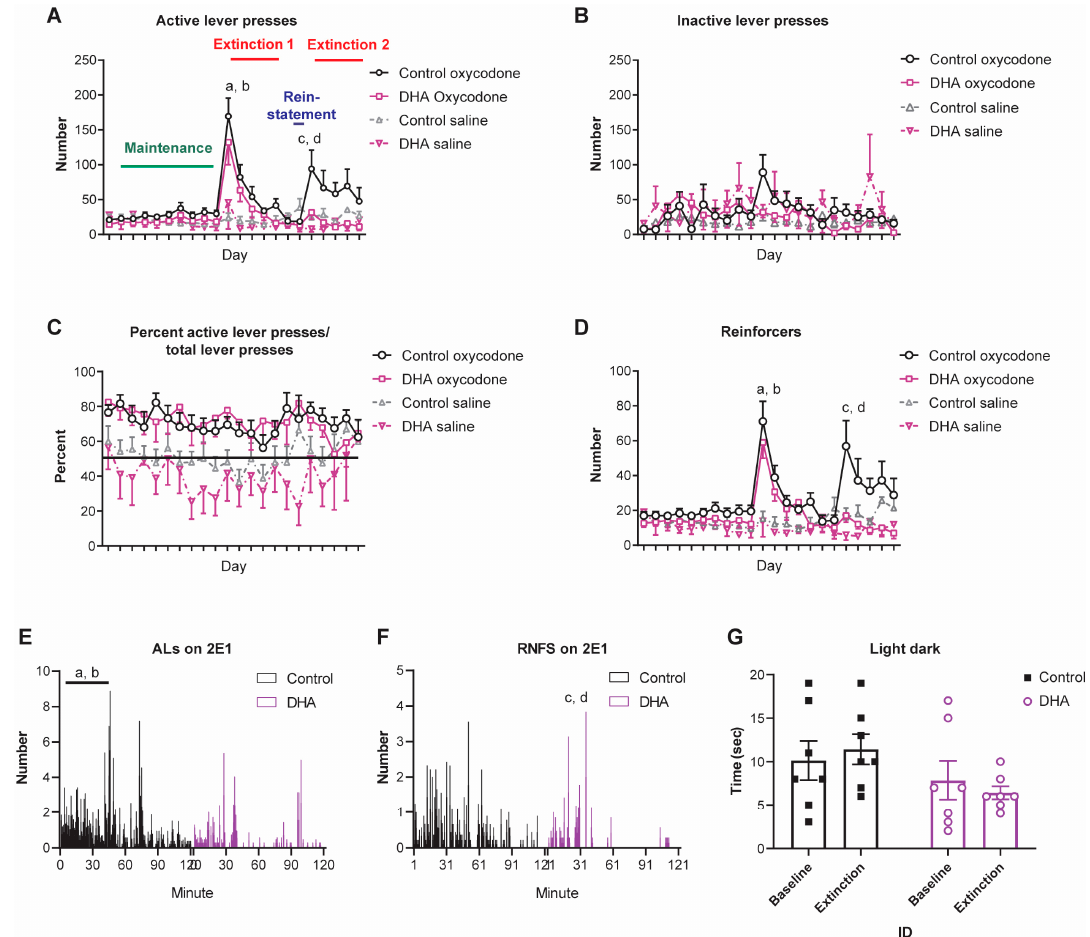
Figure 2. An n-3 PUFA-enriched diet reduces oxycodone seeking behaviors. ( A ) Active lever presses. Mice on both the control diet (black) and the n-3 PUFA-enriched diet (purple) showed an increase in AL pressing on the first day of 1E (a; p < 0.0001) and a decline in lever pressing thereafter (b; p < 0.0001). AL pressing during the reinstatement did not di ff er from the last day of 1E training or maintenance. However, during 2E, there was an increase in lever pressing above that of the reinstatement (R1 or R2 vs. 2E1; c; p < 0.01) for the control mice but not for the n-3 PUFA mice. Furthermore, active lever pressing by the n-3 PUFA mice was lower than that of the control mice for all days of 2E (d; p < 0.05). ( B ) Inactive lever presses. There was no e ff ect of diet or day on this parameter. ( C ) Percent of active lever presses. Although both saline groups showed ≤ 50% accuracy in AL presses as a percent of total lever presses, this was not di ff erent from both opioid groups with ≥ 50% AL presses. ( D ) Reinforcers. Control diet mice earned more RNFSs on 1E1 (a; p < 0.001) and this declined during the remaining days of 1E (b; p < 0.0001). The number of RNFSs earned by the controls again increased above that of the reinstatement during 2E (R1 or R2 vs. 2E1; c; p < 0.01). n-3 PUFA mice had a similar initial profile as those on the control diet with an increase in RNFS earned on 2E1 (a; p < 0.0001), and a decline in RNFS earned for each day of 1E thereafter (b; p < 0.0001). However, the 2E1–5 sessions did not induce an increase in RNFSs earned from that seen during the reinstatement. ( E ) Active lever presses during 2E1. During the first hour of this session, the control mice pressed the AL more than the n-3 PUFA mice (a; p < 0.05), and this rate declined during the second hour (b; p < 0.05). ( F ) Reinforcers during 2E1. During the second but not the first hour, the number of RNFSs earned declined more rapidly in the n-3 PUFA mice than in the control mice (n-3 PUFA vs. control diet; c; p < 0.01, and an e ff ect of time in n-3 PUFA but not control mice; d; p < 0.01). ( G ) Light–dark test. Although the n-3 PUFA intervention did not alter the basal levels of anxiety, this diet did reduce anxiety, reflected as a quicker entry into the light compartment from the dark compartment by the n-3 PUFA group on 2E2 (a; p < 0.05 vs. extinction of the control